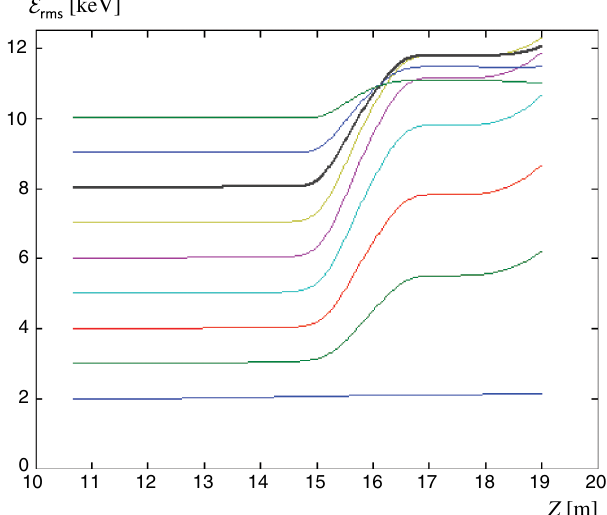
FIG. 22. Application C: energy spread after the laser heater chicane as function of the beamline coordinate. The initial spread varies due to different laser modulation.